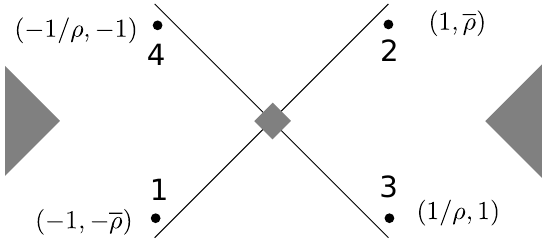
Figure 3 . The con(cid:12)guration of points that we choose, with ( u; v ) coordinates indicated. The grey region is spacelike separated from the four points. The 2 d slice shown is the plane where the four points are located. As we move the slice outwards in the transverse directions away from this plane, the inner and outer grey regions grow and eventually merge, see (cid:12)gure